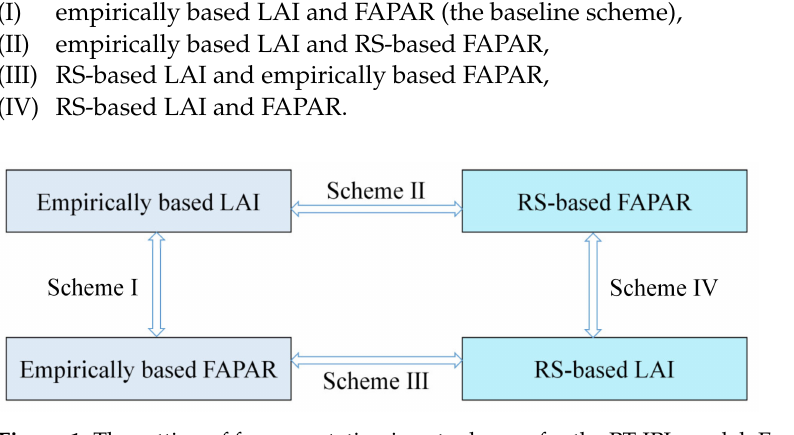
Figure 1. The setting of four vegetation input schemes for the PT-JPL model. Empirically based LAI and FAPAR represent LAI and FAPAR estimated by empirical equations. RS-based LAI and FAPAR represent remote sensing retrieved LAI and FAPAR